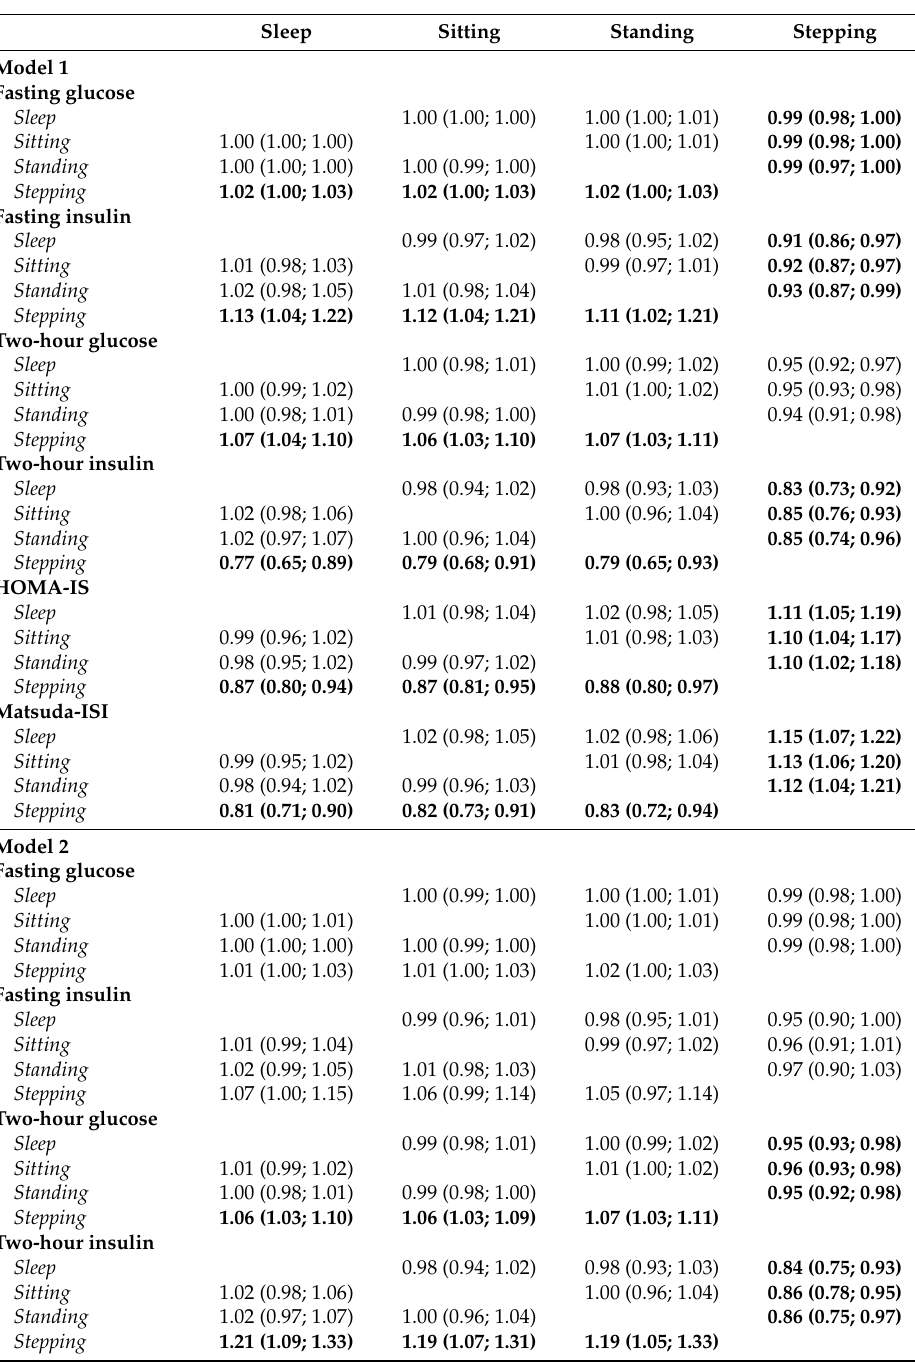
Table 5. Compositional isotemporal